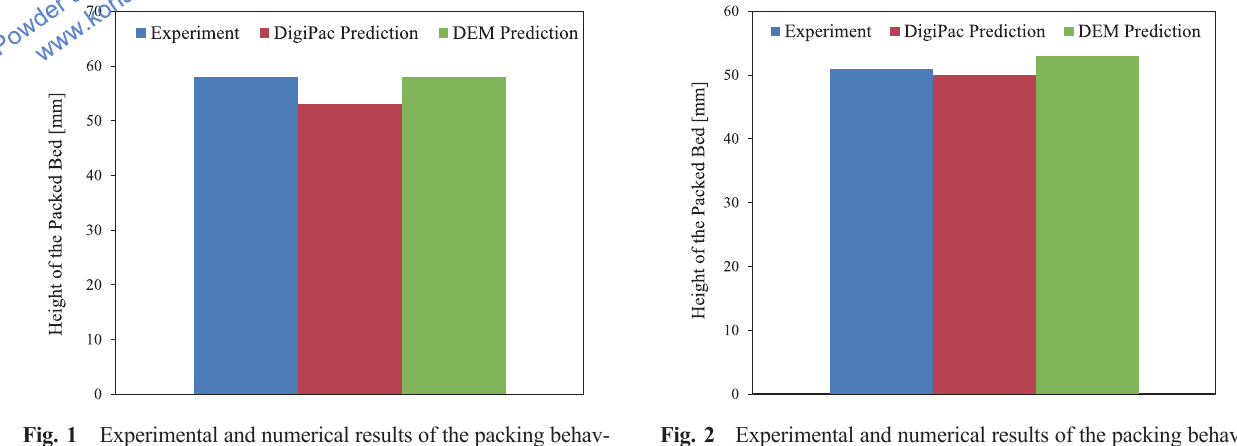
Fig. 2 Experimental and numerical results of the packing behav- ior of tubular particles.